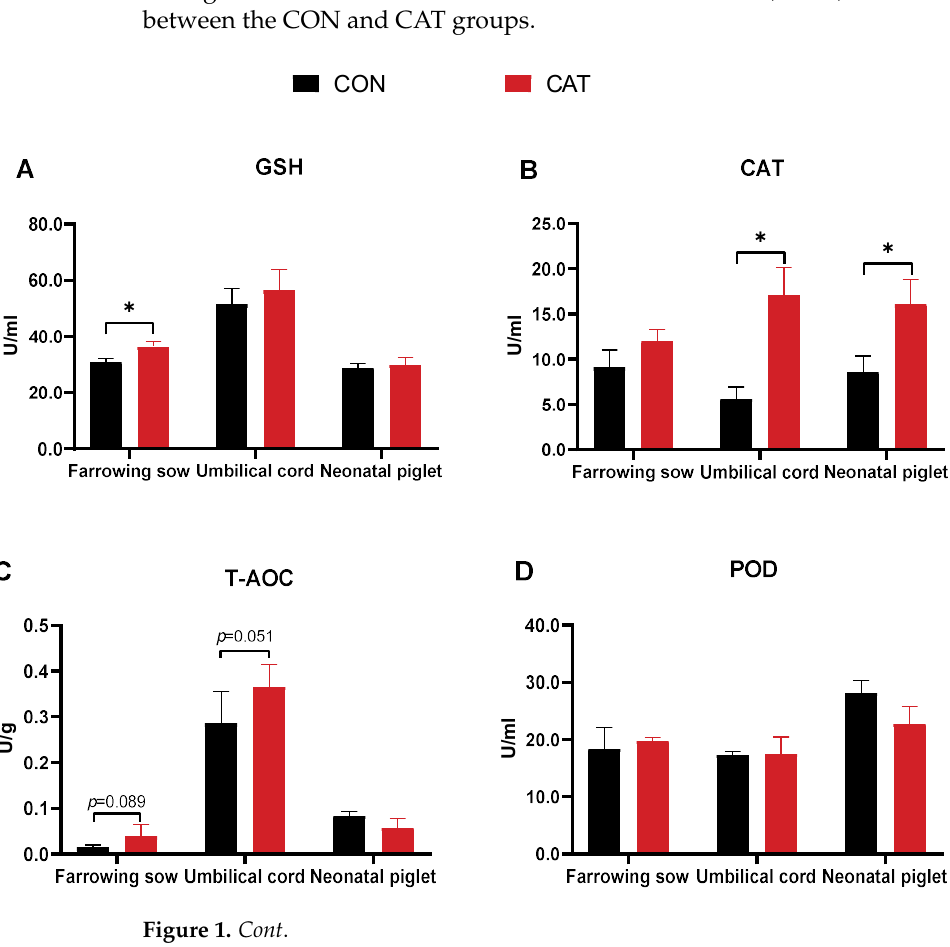
Figure 1. Antioxidant enzyme activities in serum of farrowing sows, umbilical cords, and neonatal piglets. ( A ): glutathione (GSH) activity; ( B ): catalase (CAT) activity; ( C ): Total antioxidant capacity (T-AOC); ( D ): Peroxidase (POD) activity; ( E ) Superoxide dismutase (SOD) activity; ( F ): Malondial- dehyde levels (MDA). Data are presented as mean ± SEM, n = 8. Statistical significance was set at p < 0.05. * Labeled with significant difference ( p < 0.05). 3.3. mRNA Expression of Genes Related to the Mineral Transport in the Placenta To gain further insight on the implication of CAT supplementation on placental genes related to the transport of mineral elements, we performed the gene expressions analysis by RT-qPCR (Figure 2). It was revealed that the mRNA expression of TRPV6 and CTR1 showed a significant reduction ( p < 0.05), while the mRNA expression of ATP2B tended to decrease ( p = 0.058) in the CAT group as compared with the CON group.